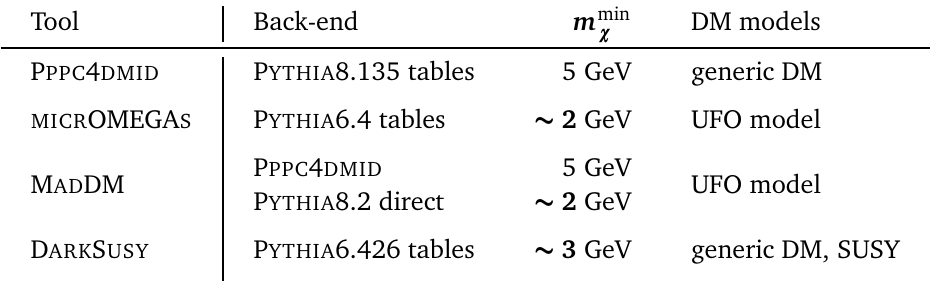
Table 1: Comparison of publicly available tools to generate spectra from DM annihi-